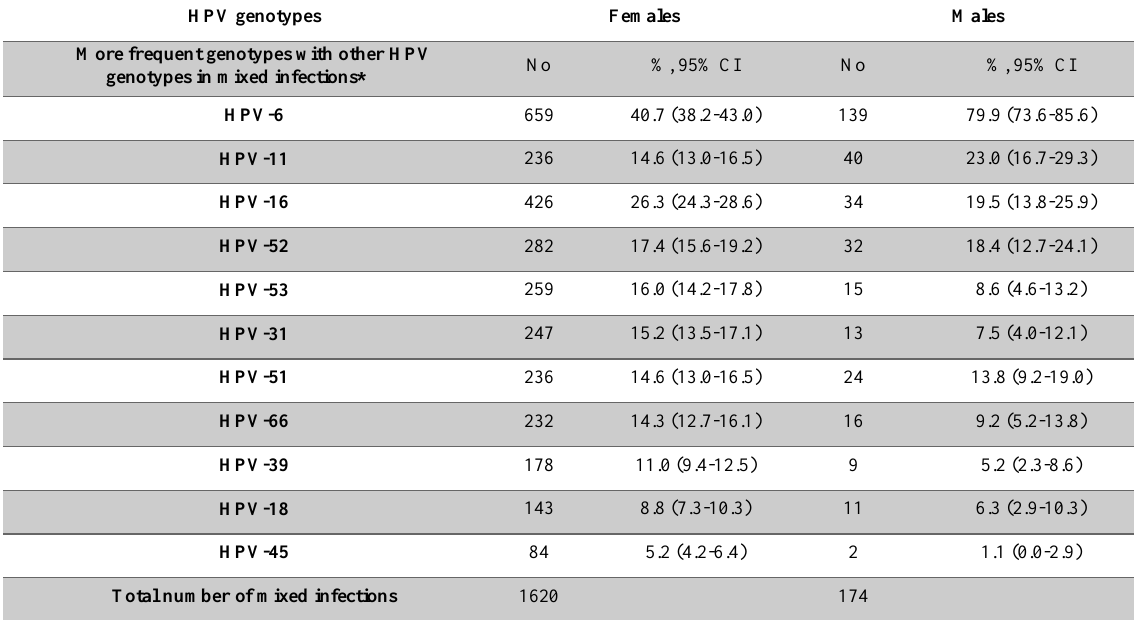
Table 2. The prevalence of HPV genotypes in mixed infections in Iranian female and male population